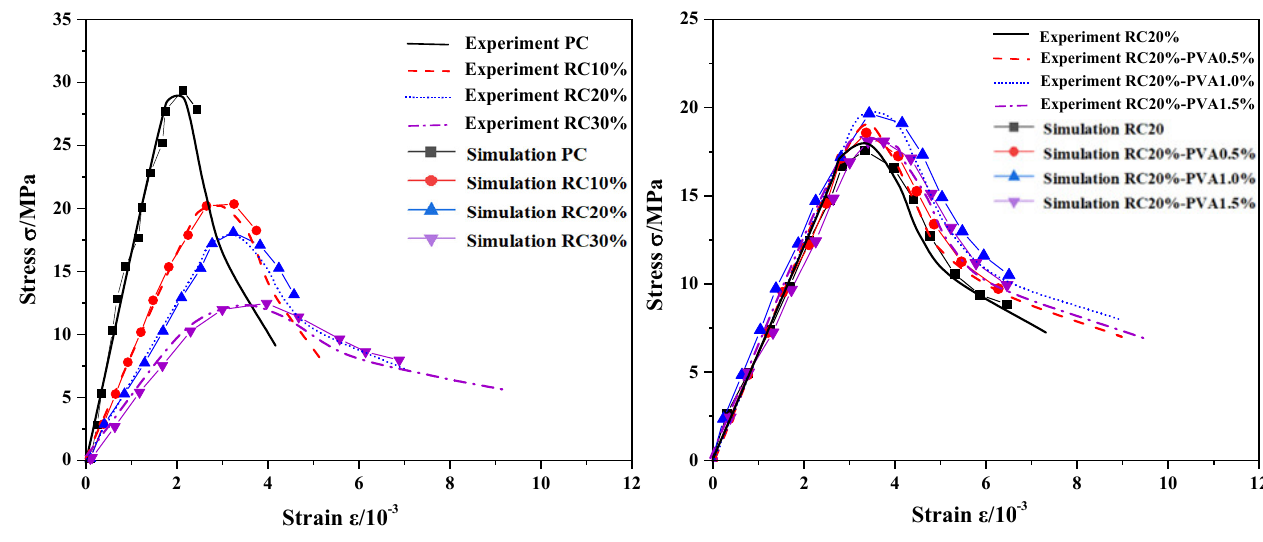
Figure 17. Comparison of experimental and simulation results.